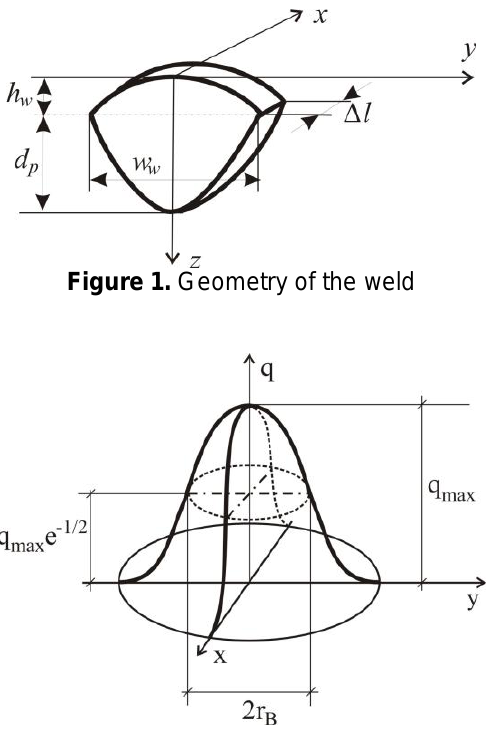
Figure 2. Gaussian distribution of heat source